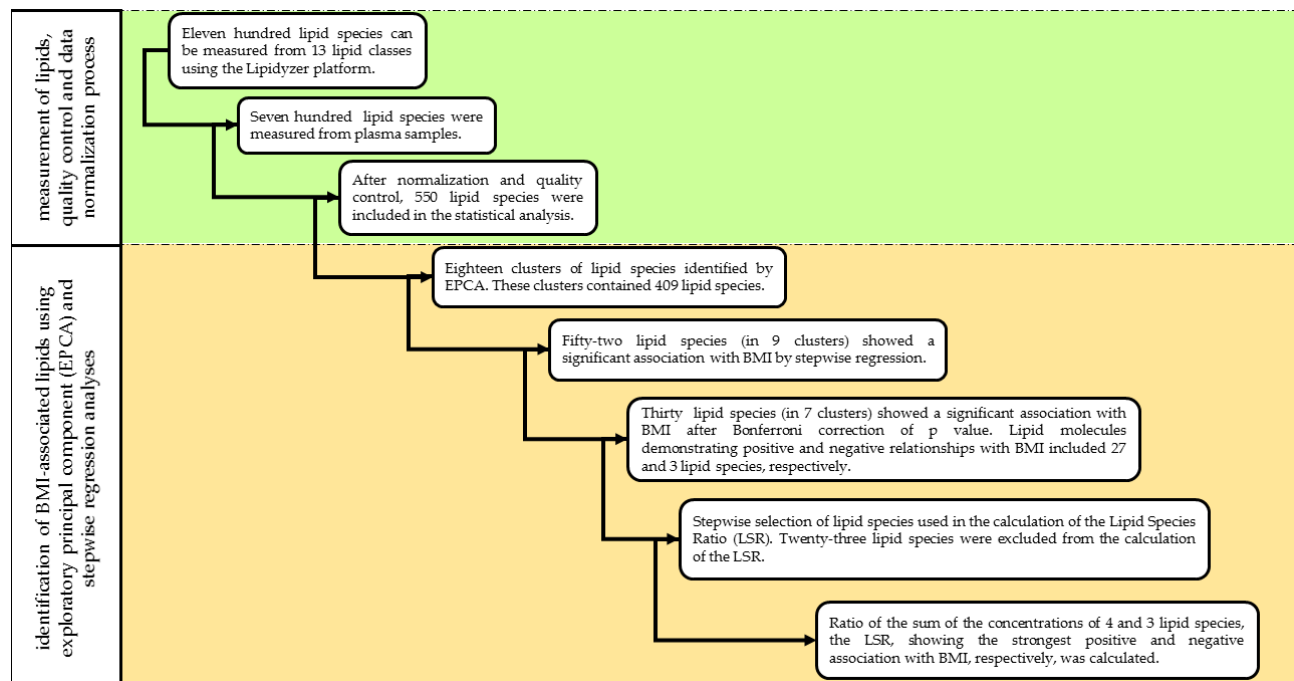
Figure 2. Flowchart of statistical analysis.